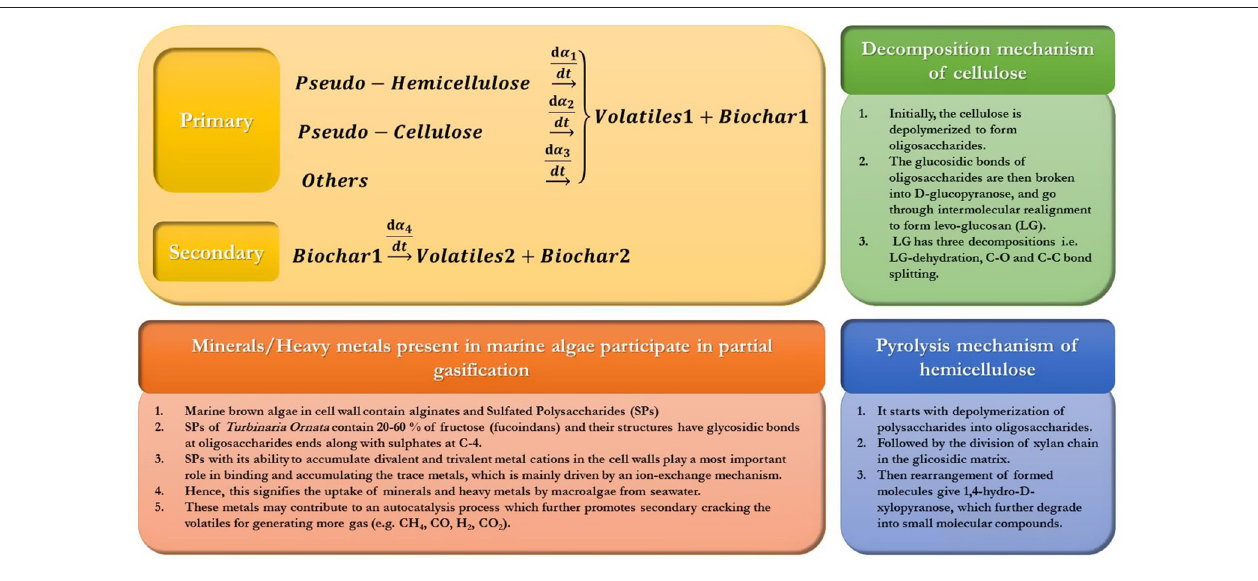
FIGURE 2 | Primary and secondary reactions during pyrolysis of Turbinaria